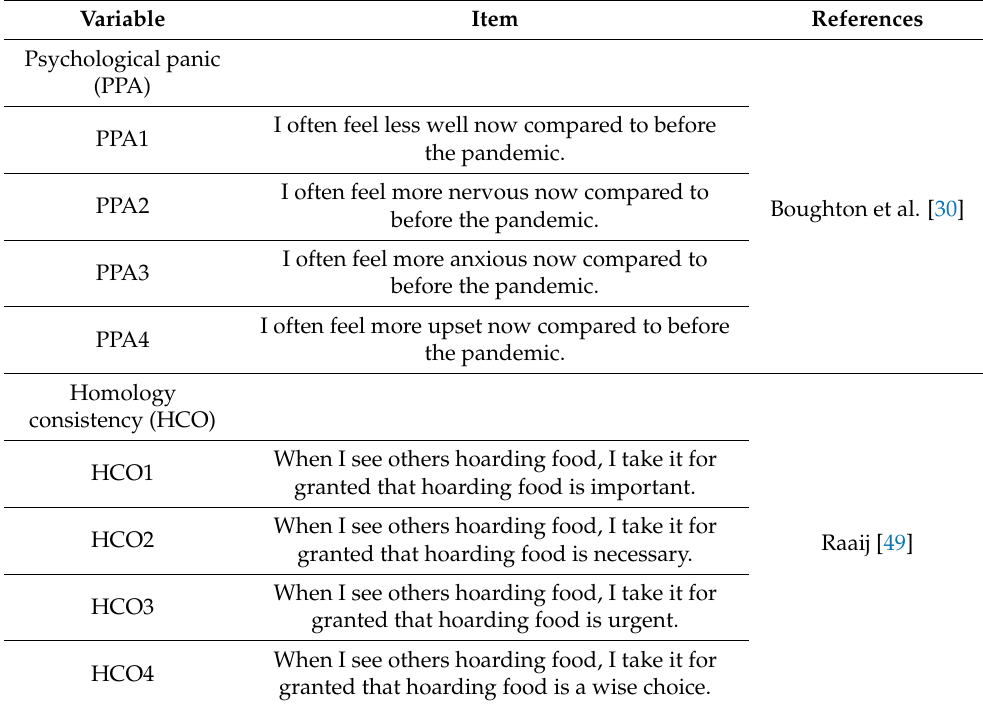
Table 2. Survey items related to citizens’ irrational food hoarding